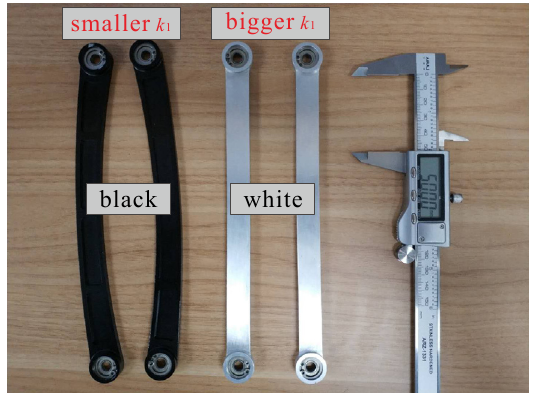
Figure 14. Two types of linkages with different stiffness for experiments.44